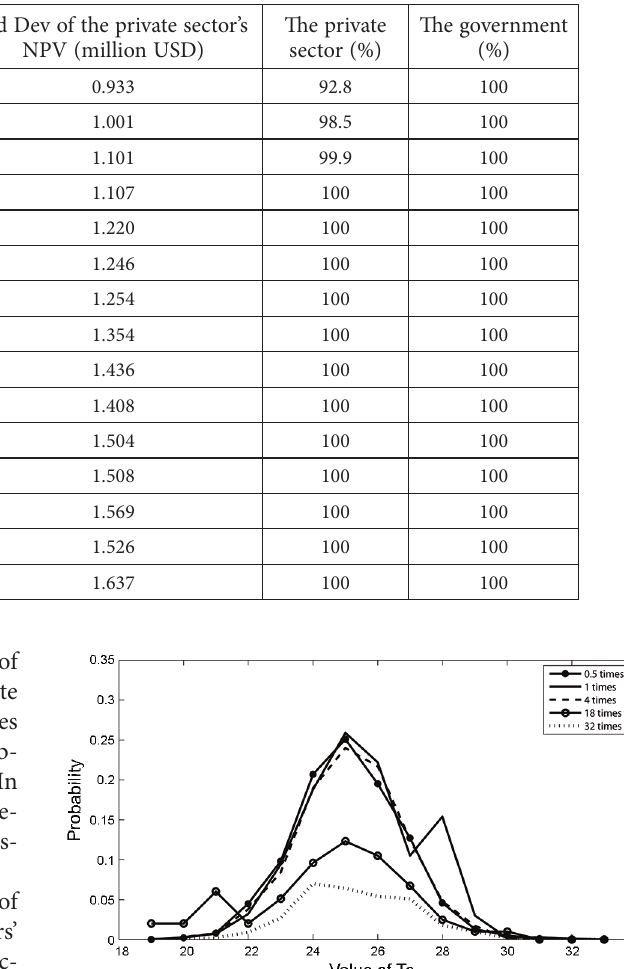
Table 1. Simulation results of the private sector’s NPV and cumulative probability of satisfying benefits of the